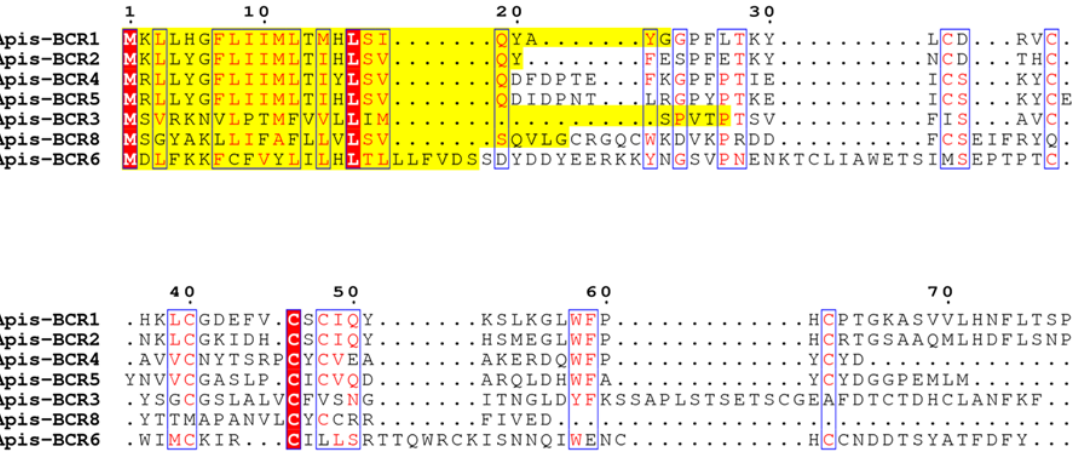
Figure 1. Multiple sequence alignment of Acyrthosiphon pisum BCRs. The number and the spacing between these cysteine residues allow to distinguish four BCR sub-families: BCR1-2-4-5, BCR3, BCR8 (containing all six cysteines) and BCR6 (eight cysteines). The signal peptides predicted by SignalP 6.0 server [23] of BCR sequences are highlighted in yellow. The fully conserved residues are framed and highlighted in red.